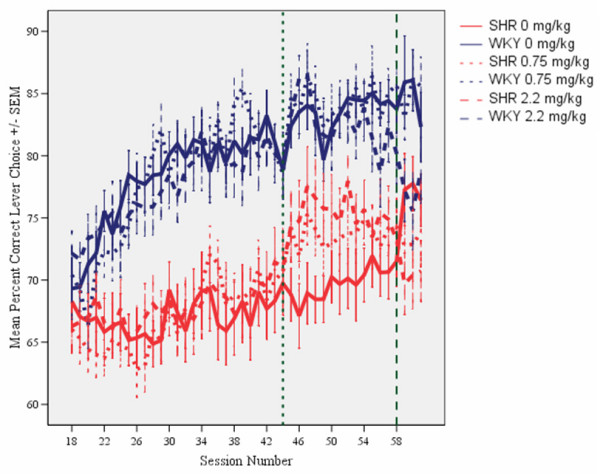
Effects of l-amphetamine on sustained attention, choice of the correct lever in percent of all lever presses, by SHR and WKY controls. Means ± SEM. Sessions 31 through 44 served as baseline sessions. Treatment was given at sessions 45 through 58. Sessions 59 through 61 were used for studying post-treatment effects, except for the groups that received vehicle (saline, 0 mg/kg) during treatment sessions 45-58. These groups received 2.2 mg/kg l-amphetamine to check for typical responsiveness to the drug for SHR and WKY.